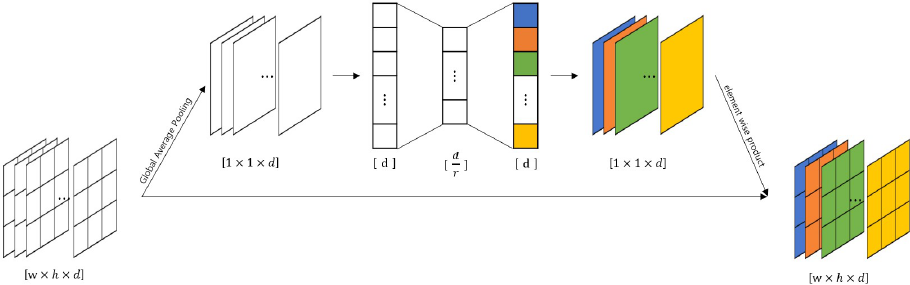
Figure 3. Illustration of the SE block; different colors represent each different